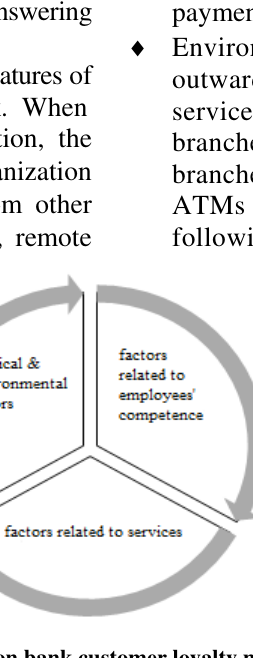
Fig. 2. Effective factors on bank customer loyalty model (Richeld, 1994)